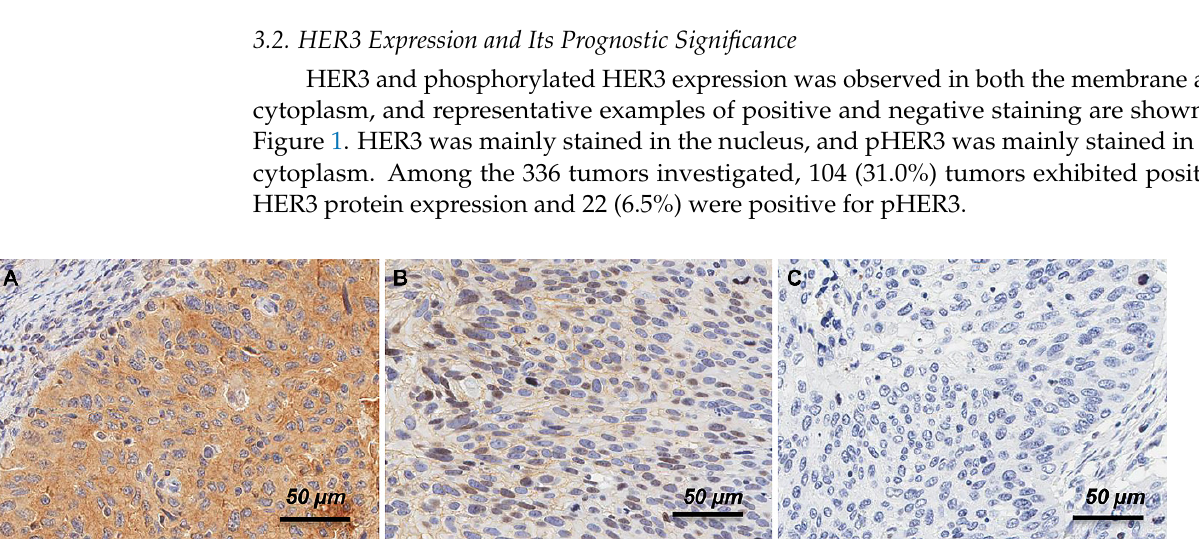
Figure 1. Immunohistochemical expression of ( A ) HER3, ( B ) pHER3 protein, and (C) the negative expression of HER3/pHER3 protein in cervical cancer patients.